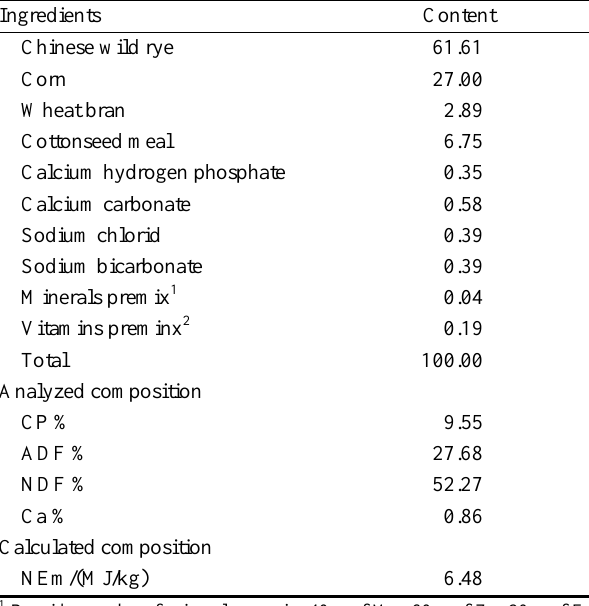
Table 2. Ingredients and chemical composition of the basal diet